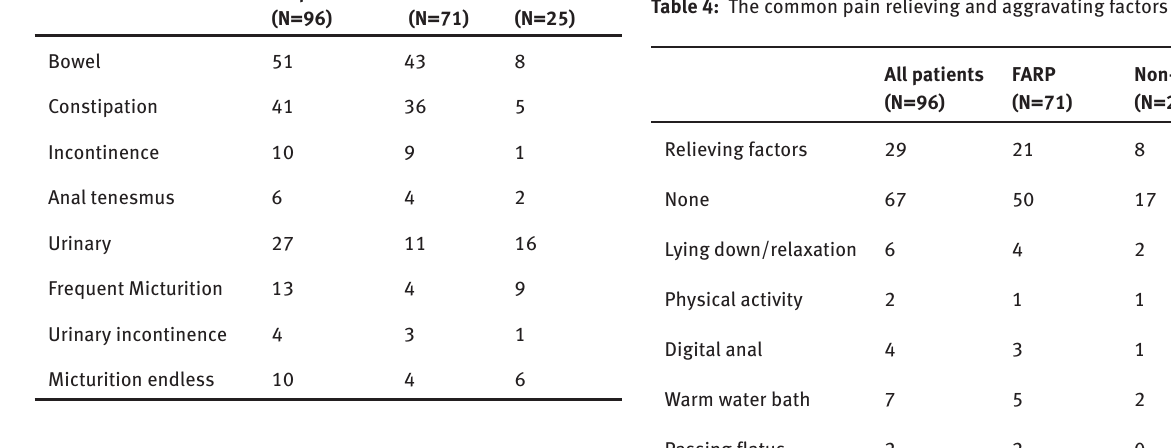
Table 3: Initial event marking the onset of the anal pain